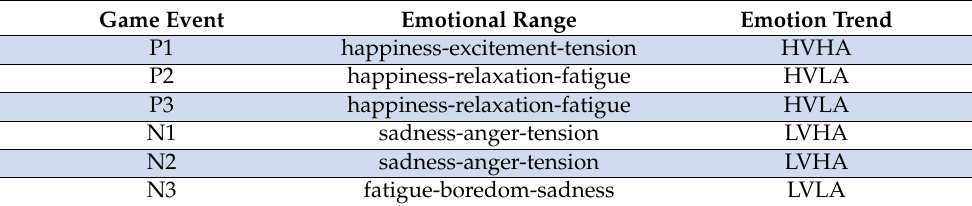
Table 2. Emotional range of six game